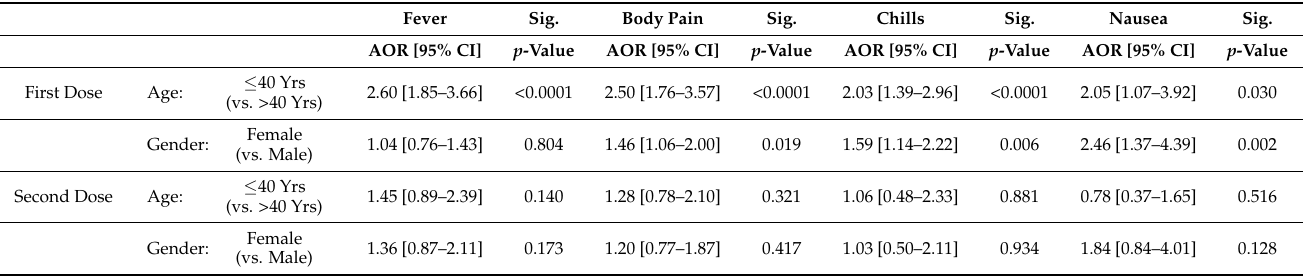
Table 4. Multiple logistic regression: effect of age and gender on fever, body pain, chills, and nausea side effects. Fever Sig. Body Pain Sig. Chills Sig. Nausea Sig.